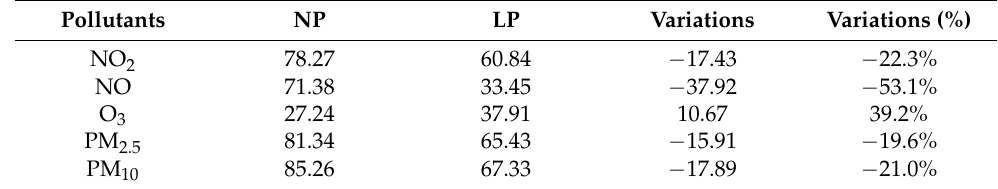
Table 7. Average concentration and variation of pollutants during the NP and LP in